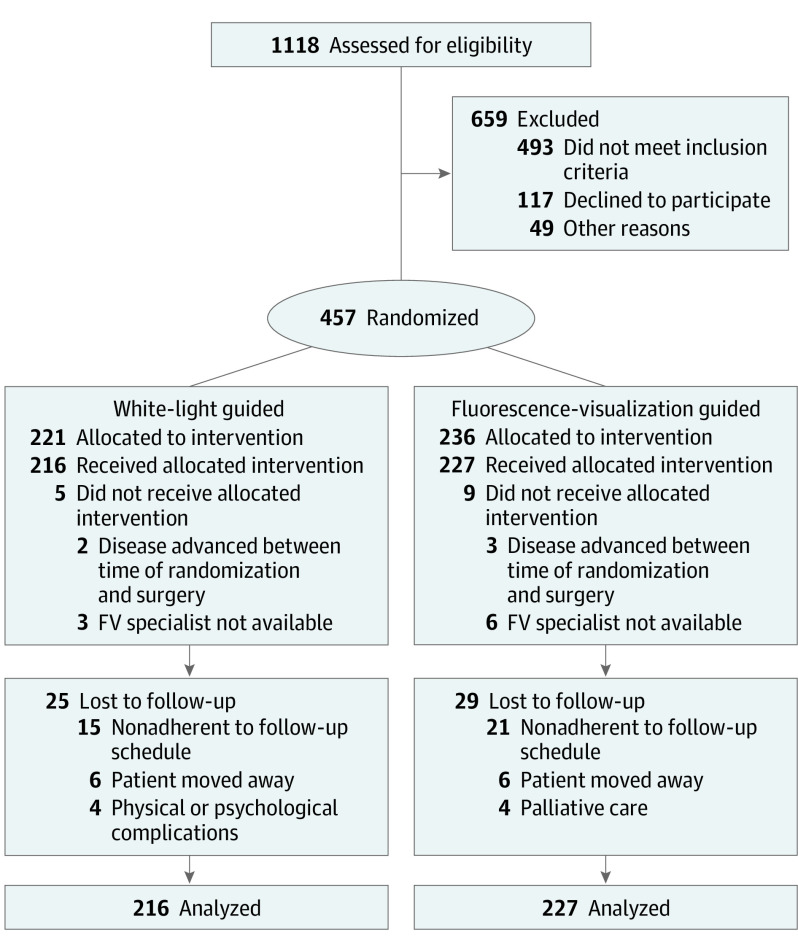
CONSORT Flow DiagramFV indicates fluorescence visualization.